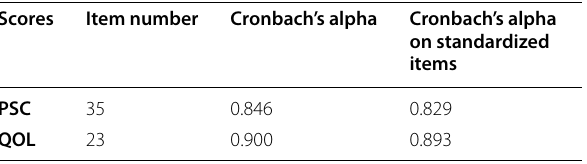
Table 6 Total Cronbach’s alpha of Pediatric Symptom